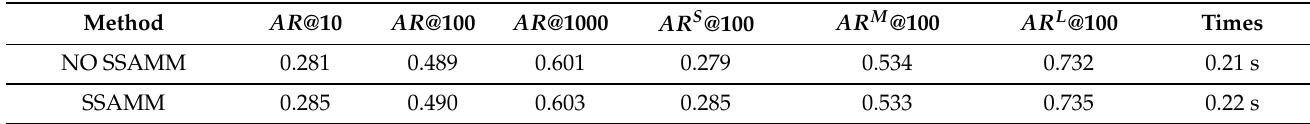
Table 8. Results of MSA-RPN with and without